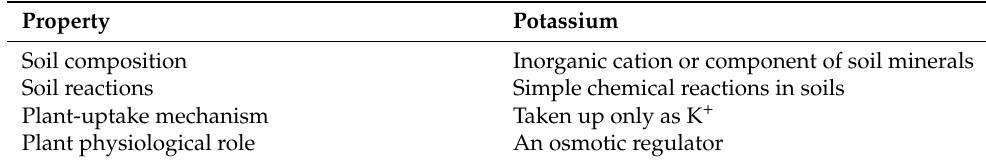
Table 1. Properties of potassium in soil and